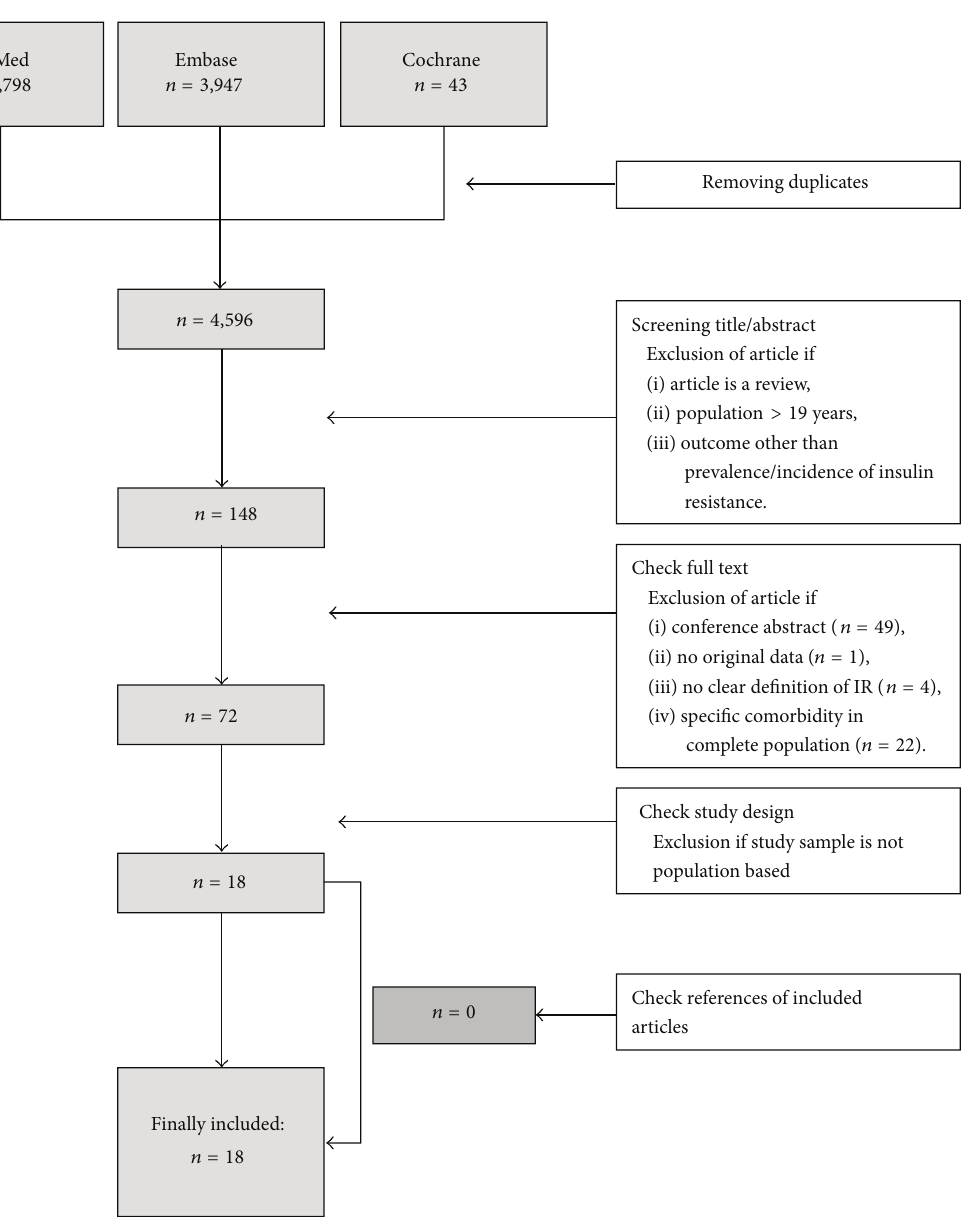
Figure 1: Flowchart of search and included